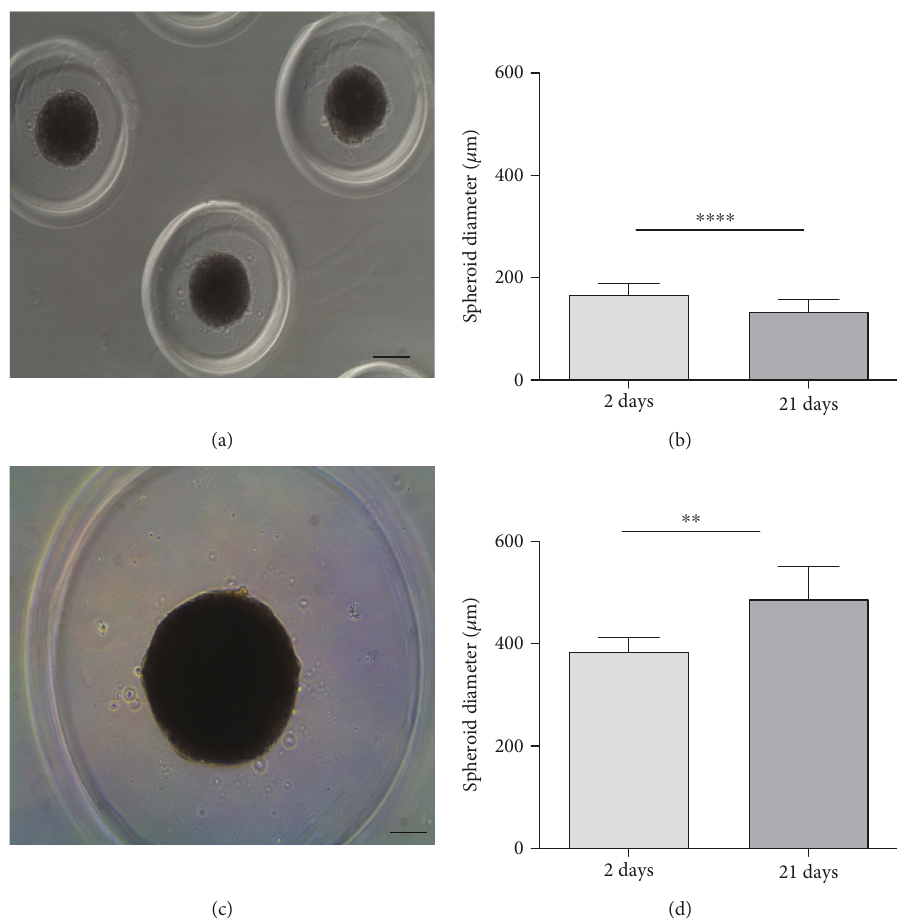
Figure 2: The CPC spheroids formed in the micromolded nonadhesive hydrogel with 800 μ m diameter in each circular recesses showed stability in their diameter along 21 days of cell spheroid culture. (a, c) Representative images of CPC spheroids formed in micromolded nonadhesive hydrogel with 300 μ m diameter (a) and with 800 μ m diameter in each circular recesses (c). Phase contrast microscopy. Bar size: 100 μ m. (b, d) The graphs represent the mean ± standard error of the spheroid diameter in micromolded nonadhesive hydrogel with 300 μ m diameter (b) and with 800 μ m diameter in each circular recesses (d). Light gray bar represents 2 days of cell spheroid culture. Dark gray bar represents 21 days of cell spheroid culture. ∗∗∗∗ p < 0 0001 ; ∗∗ p < 0 01